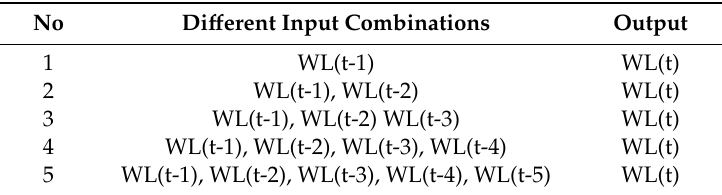
Table 1. The selected scenarios for input